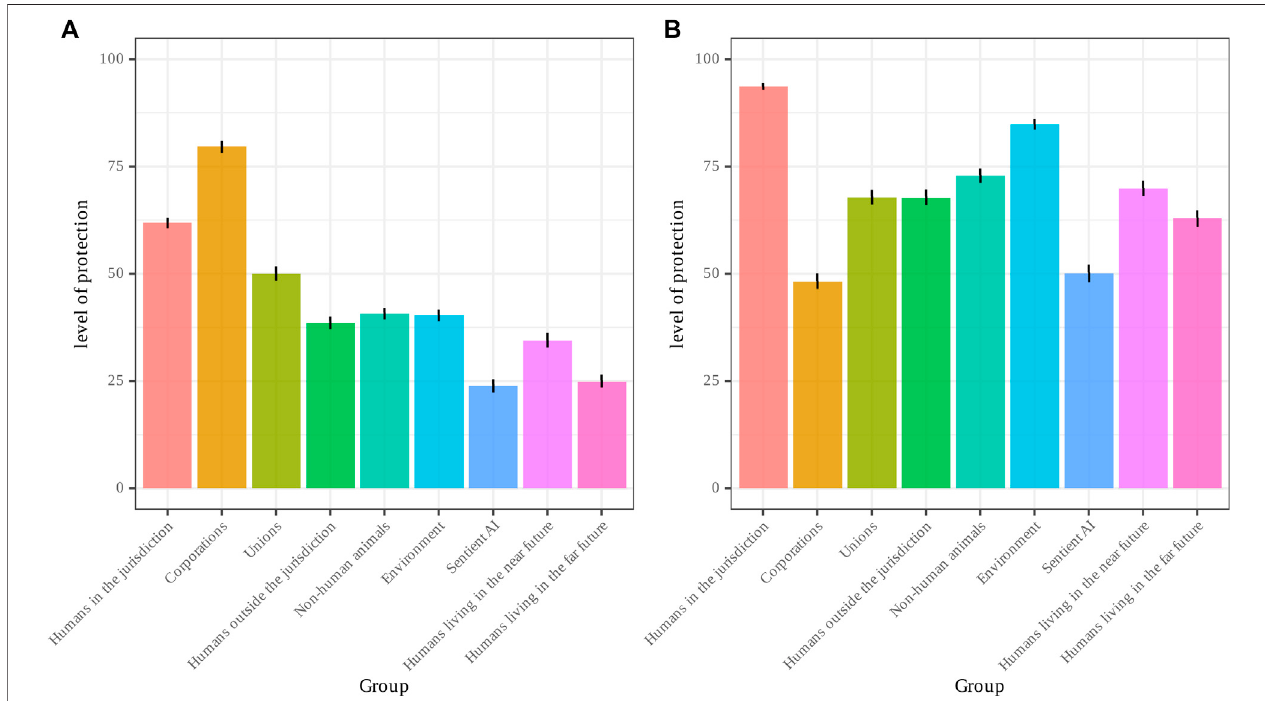
FIGURE 1 | (A) Perceived current and (B) desired legal protection for sentient Al and other groups.